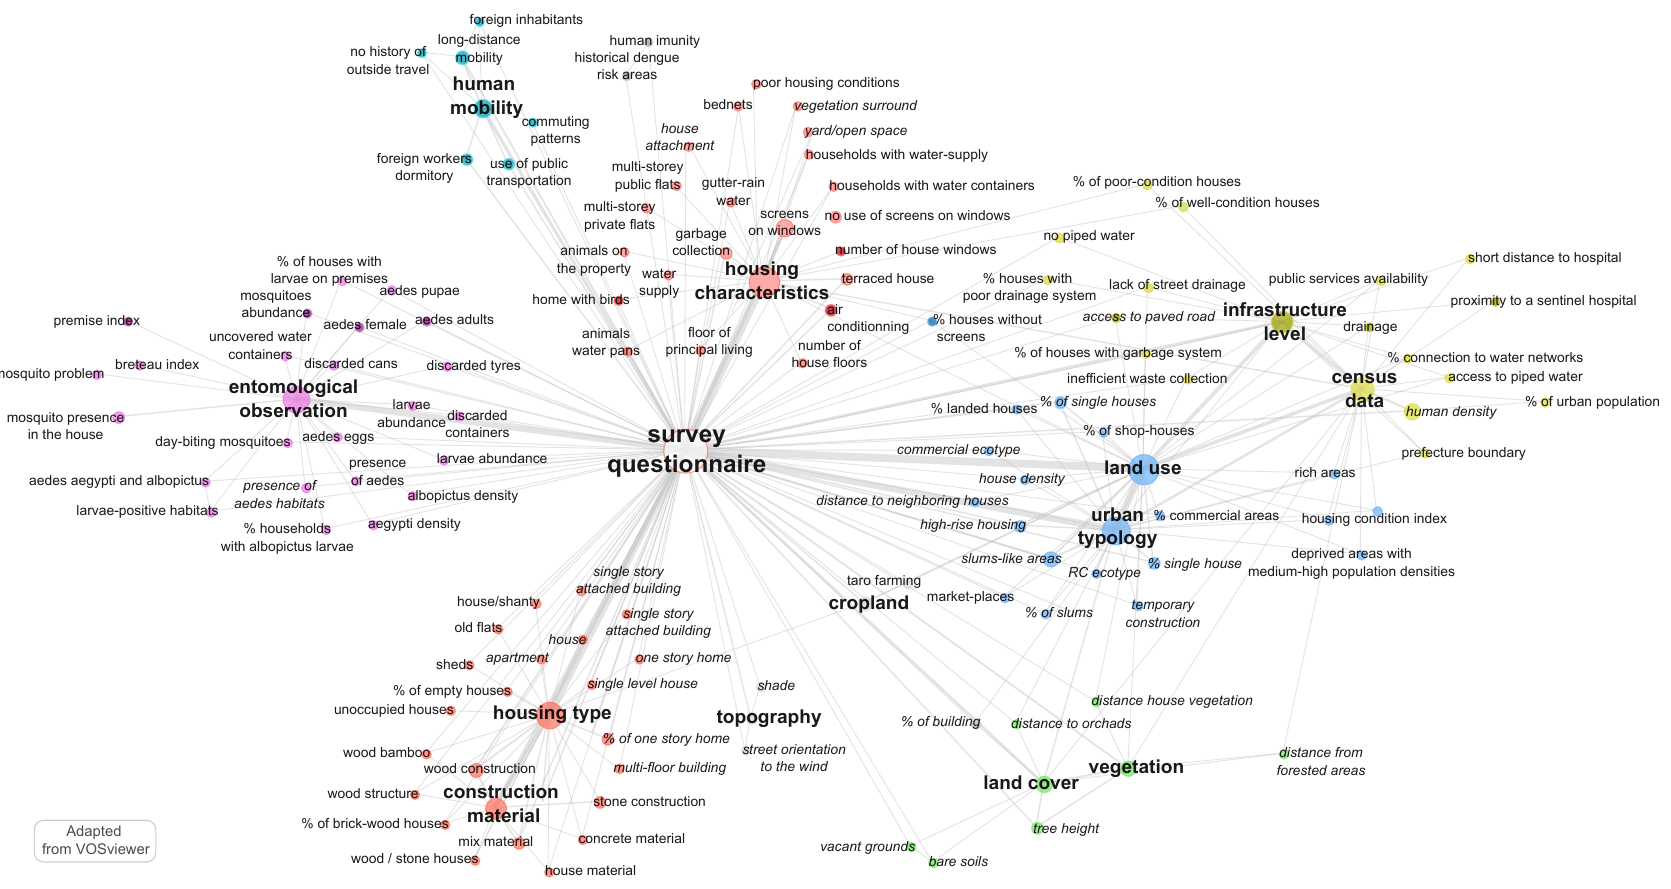
Figure 6. Co-occurrence network mapping of the self-defined keywords related to the article using survey questionnaires to produce the landscape factors. We indicate in orange those factors that could also be produced through remote sensing